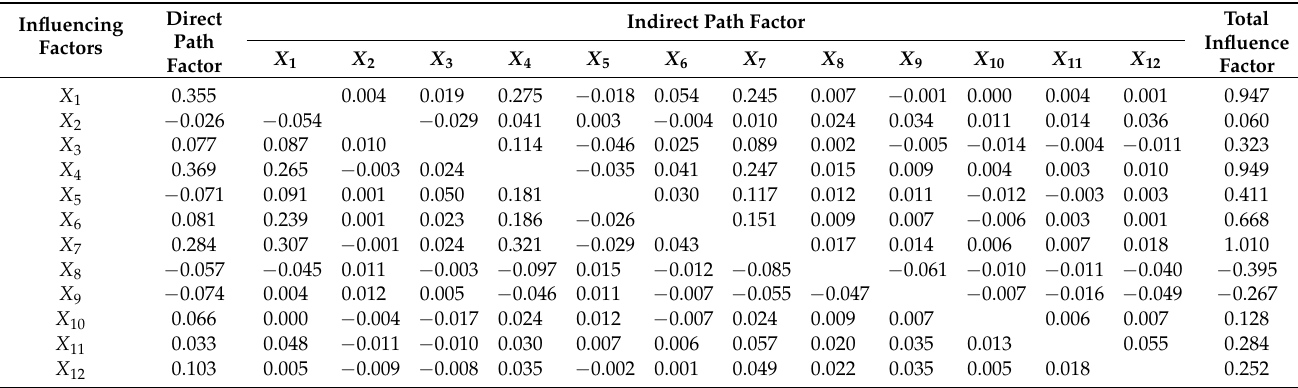
Table 5. Analysis results of influencing factors of spatial variation of AWF grey in the Yellow River